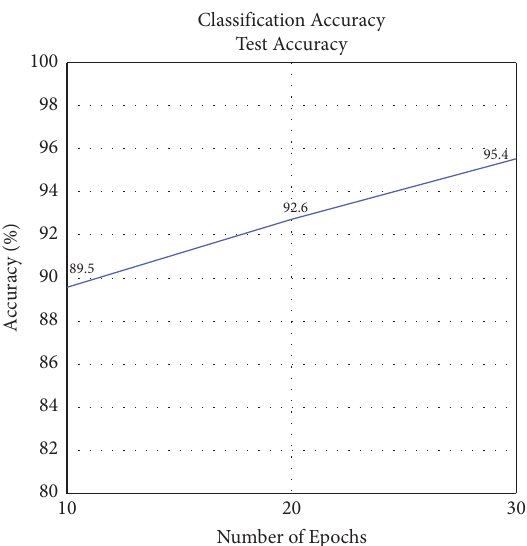
Figure 7: Classifcation accuracy of VGG-16 using RmsProp optimizer.